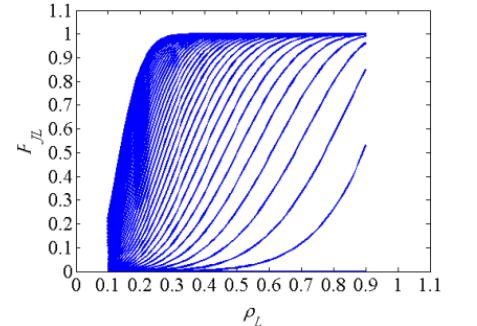
Fig.6 Left-turn vehicle was disturbed by the straight-cross Vehicle, n v ∈（ 1~40